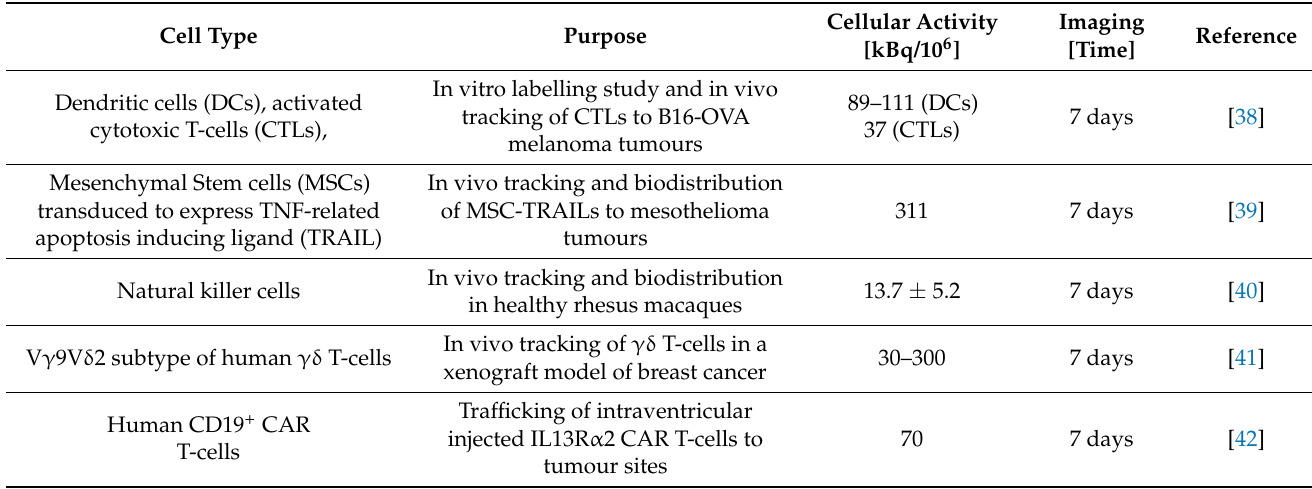
Table 1. Preclinical cell labelling and imaging studies using 10 6 –10 7 cells labelled with [ 89